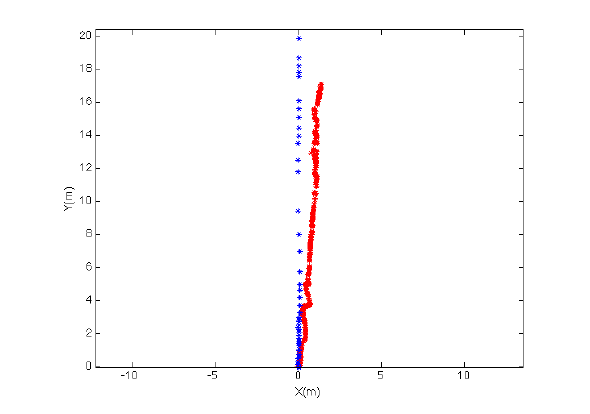
Figure 15: Comparison between estimated path (in red) and path obtained via total station (in